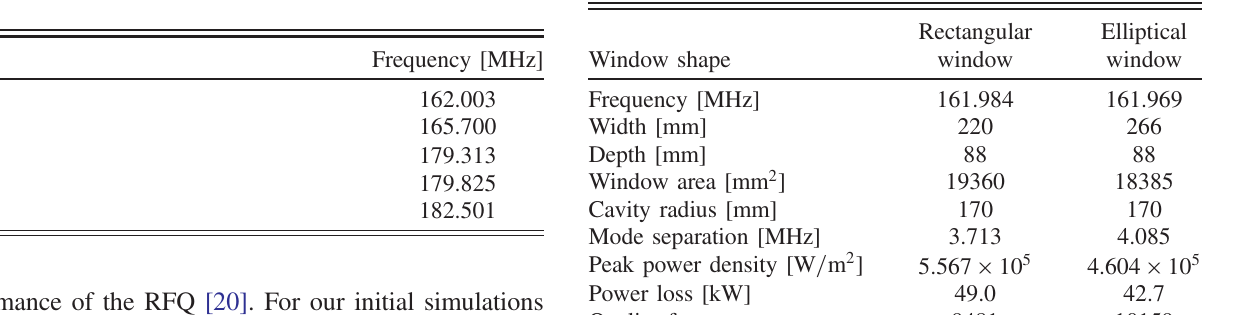
TABLE III. Characteristics of two different window shapes.